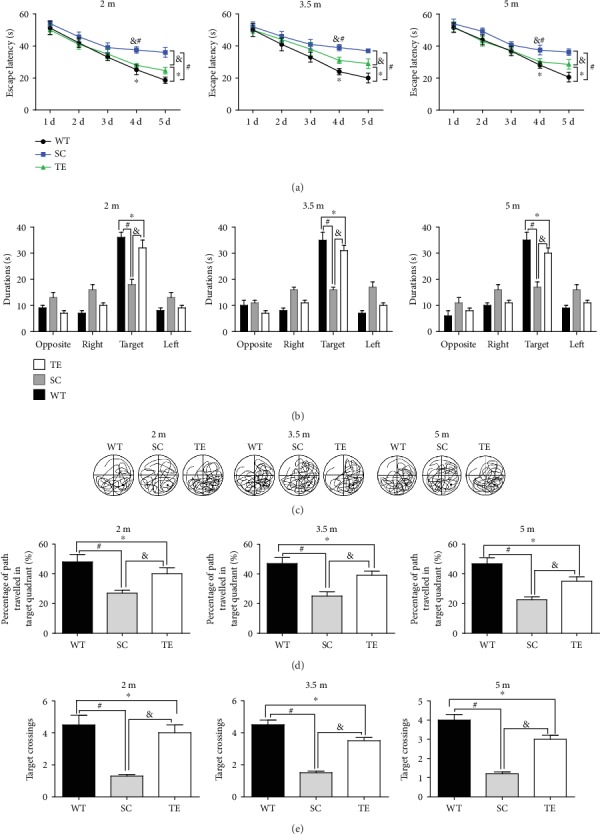
24-week treadmill exercise improved spatial learning and memory in APP/PS1 mice. In the hidden platform test, the escape latencies of WT or APP/PS1 mice over 5 d were recorded (a). In the probe test, the percentage of time spent in the target quadrant (b), typical probe traces (c), percentage of path traveled in the target quadrant (d), and number of target crossings (e) for 2 m, 3.5 m, and 5 m WT and APP/PS1 mice with or without exercise and WT mice were compared. WT: wild type; SC: sedentary control; TE: treadmill exercise. ∗WT vs. TE, P < 0.05; #WT vs. SC, P < 0.05; &TE vs. SC, P < 0.05.